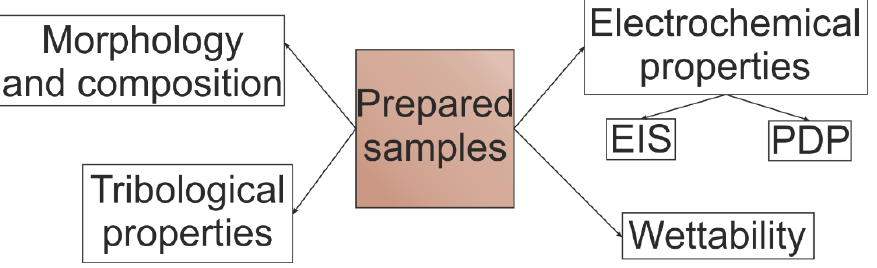
Figure 3. Scheme of the used analysis of samples.